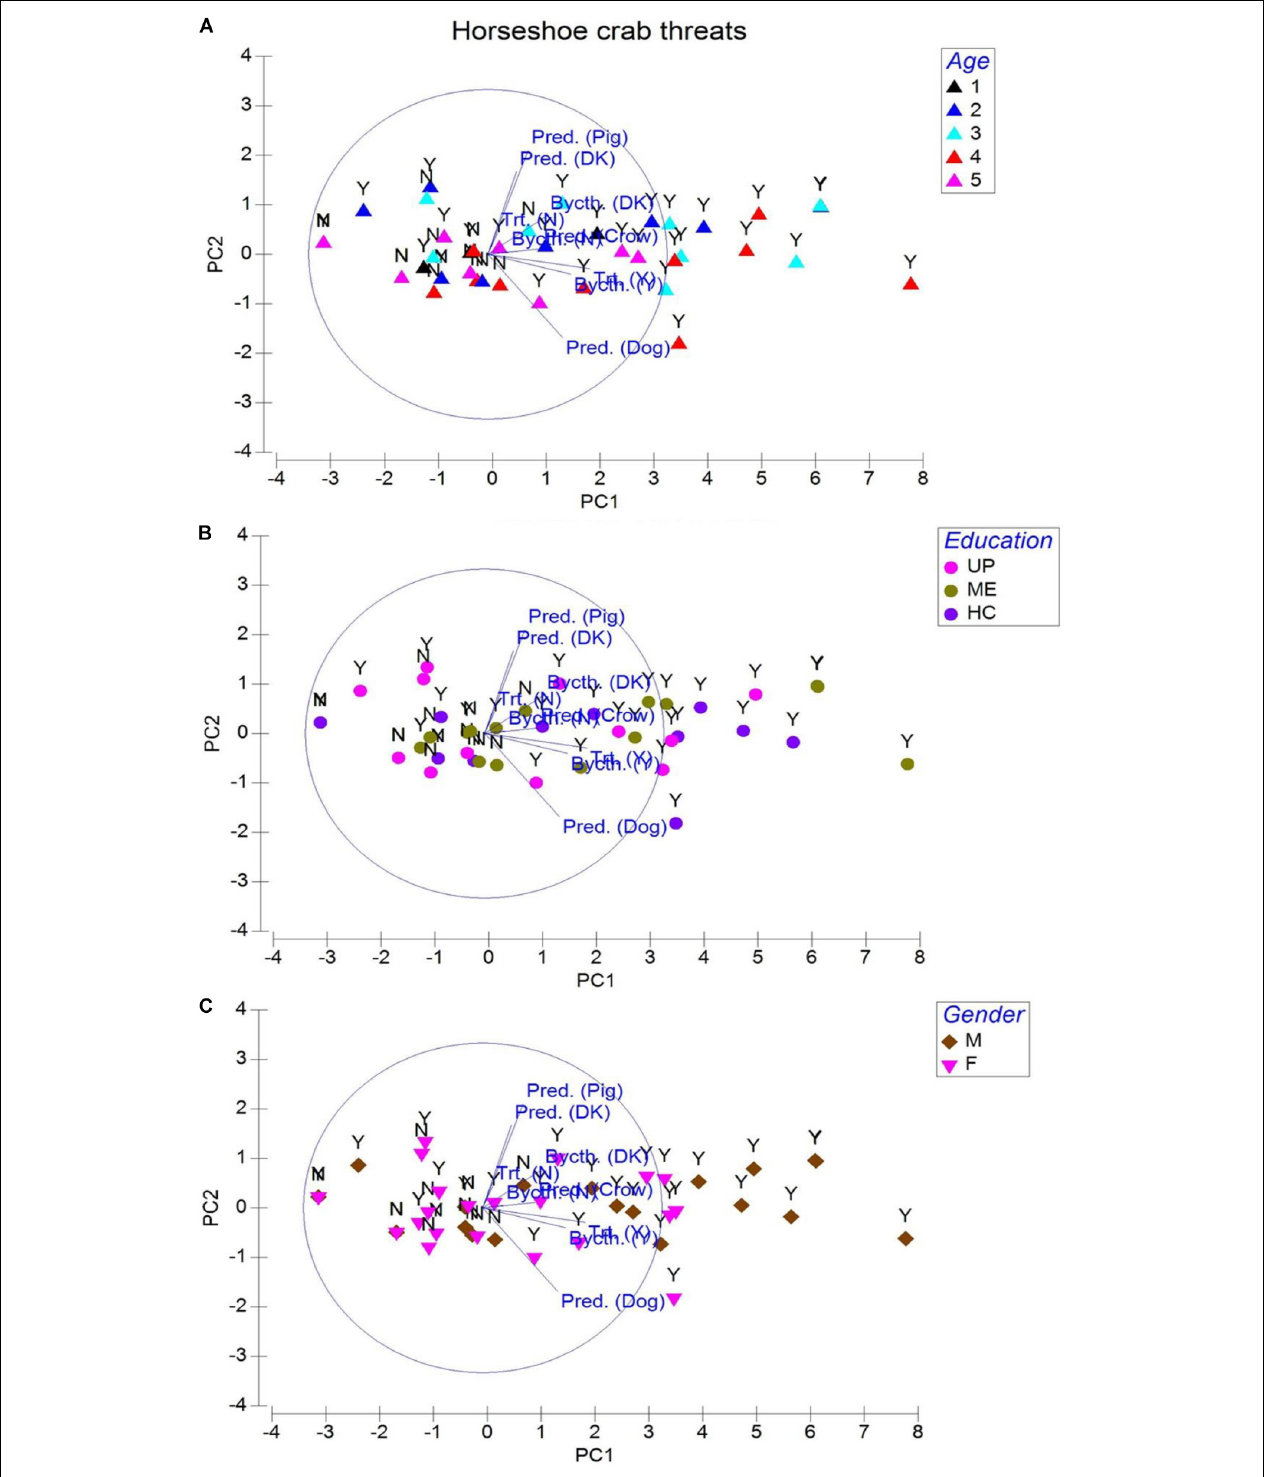
FIGURE 5 | Principal component analysis for society perception of threats to the horseshoe crab, Tachypleus gigas. Abbreviations are pred. = predation, bycth = by-catch, Trt. = threats, DK = don’t know, Y = yes, and N = no. Legends represented by age are 1 = 18–24 (Group 1), 2 = 25–34 (Group 2), 3 = 35–44 (Group 3), 4 = 45–54 (Group 4), and 5 = 55–64 (Group 5). Education is denoted with UP = upper primary, ME = middle elementary, and HC = high school; gender is represented by M = male and F = female respondents.